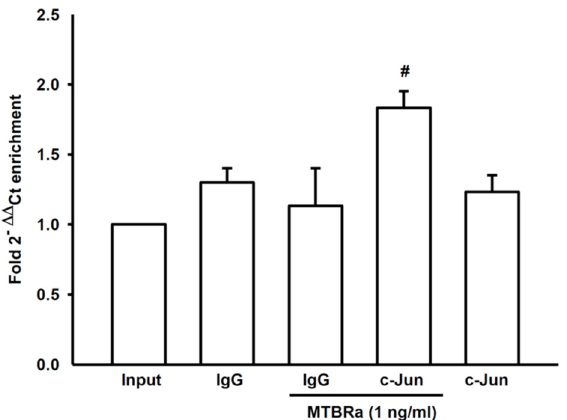
Figure 4. MTBRa stimulates the binding of AP-1 to the promoter of VEGF in human PMCs. ChIP- qPCR analysis of the binding of AP-1 (c-Jun) to the genomic region of VEGF with input normalization and IgG control in MeT-5A cells treated with MTBRa for 15 min. The relative fold enrichment data were expressed as mean ± SEM of three independent experiments. # p < 0.05 compared with MTBRa-treated IgG control group. MTBRa, Mycobacterium tuberculosis H37Ra; PMC, pleural meso- thelial cell; VEGF, vascular endothelial growth factor; ChIP-qPCR, chromatin immunoprecipitation- quantitative PCR.